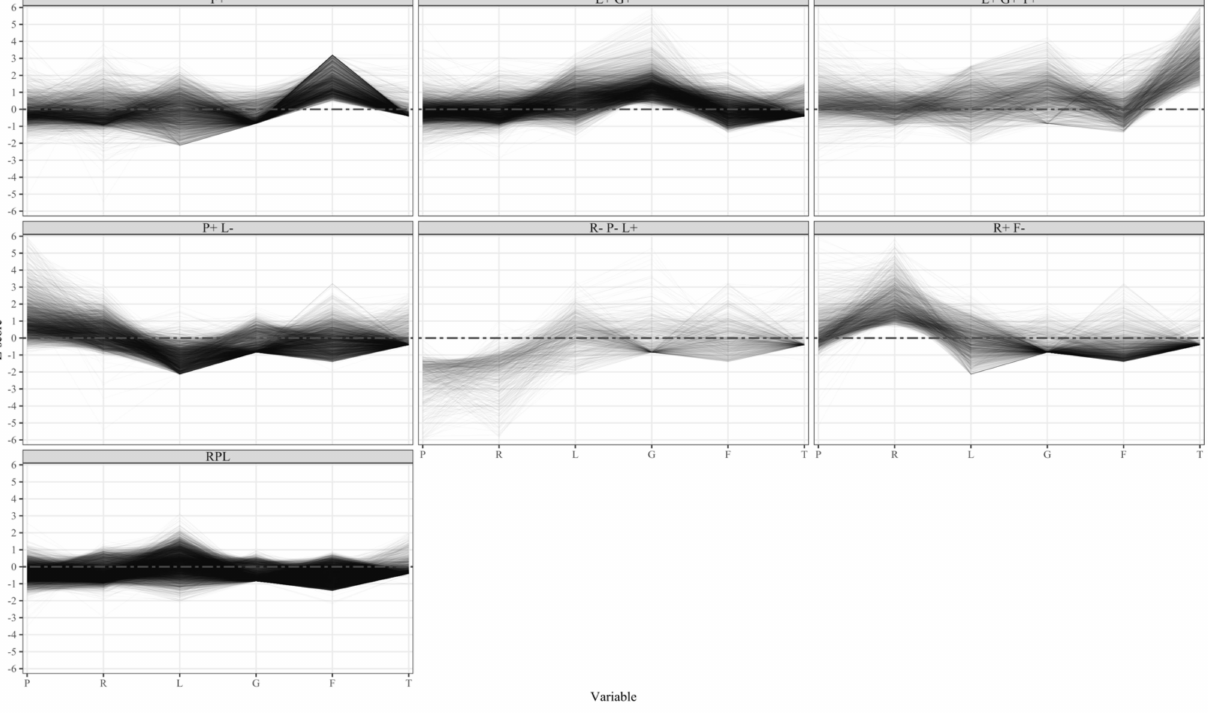
Figure 6. Seven-cluster partitioning assumed as a final